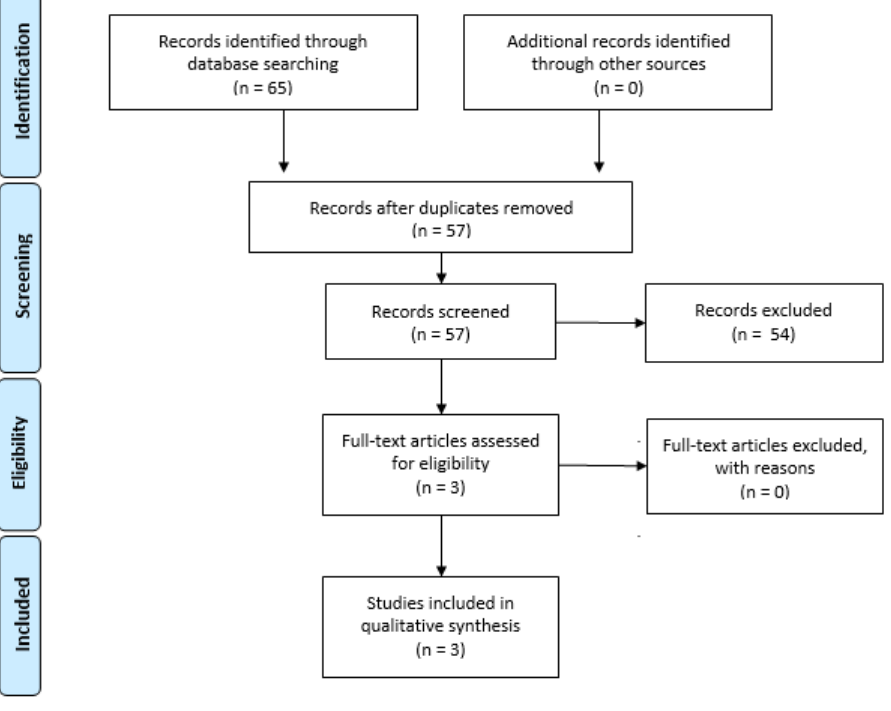
Figure 1. Flow diagram of the adapted research